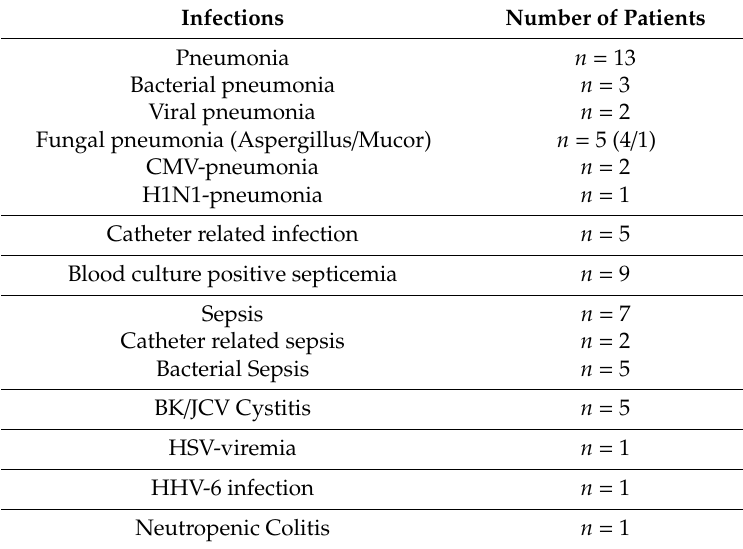
Table 3. The list of infections in the follow-up of AHSCT.